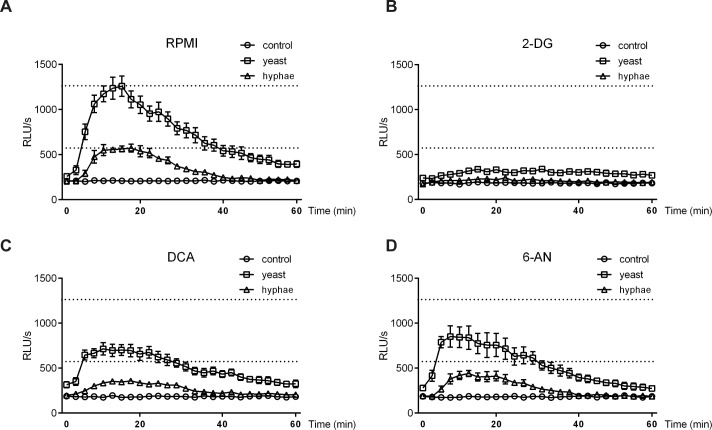
ROS production by monocytes involved glycolysis and the pentose phosphate pathway.(A-D) Human monocytes were treated with medium (A), 2-DG (B), DCA (C) or 6-AN (D) and subsequently stimulated with medium, heat-killed C. albicans yeast or heat-killed C. albicans hyphae. Luminescence generated from ROS production was measured every 145 seconds during 60 minutes (n = 4; pooled from 2 independent experiments). Dashed lines show maximum ROS levels reached without inhibitor treatment to be used as a visual reference.